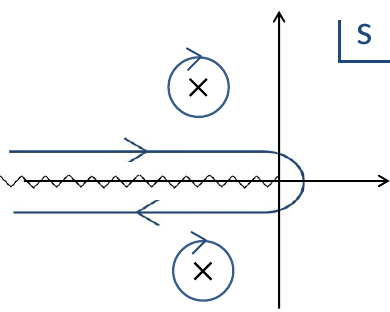
Figure 1 . The contour for the inverse Laplace transform used to compute the fundamental solutions G 1 ( t ) and G 2 ( t ) with the existence of the cut and the